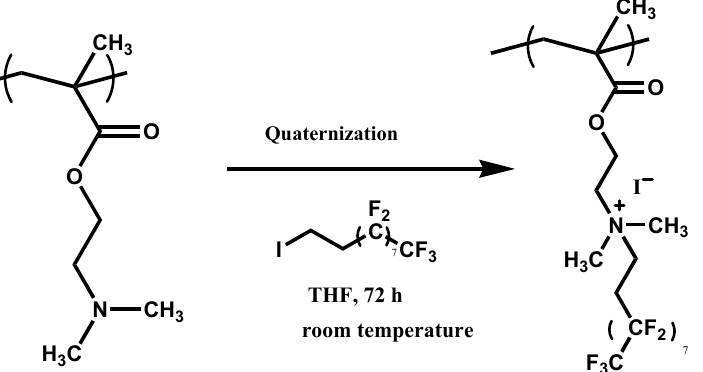
(b) Figure 2. 1 H − NMR spectra of the ( a ) quaternized PQFD 10% and ( b ) quaternized PQFD20%am- phiphilic copolymers . The peak at 7.2 ppm (*) is assigned to the solvent protons. The characteristic chemical shifts were determined based on literature data[33]. The peak a at 1.28 ppm in Figures 2a, b corresponds to the protons of the skeletal CH 2 groups, while peak b is assigned to the methyl group protons. Peaks c and d found at 4.07 ppm and 2.62 ppm, respectively, correspond to protons of ethyl groups. Characteristic peak e appearing at 2.32 ppm is assigned to protons of the tertiary amine group. Protons of the qf17 group that is attached to certain amino groups are found at 2.62 and 2.18 ppm, re- spectively. It is obvious that the peaks of the d and g proton overlap. Finally, the methac- rylate group f protons of the quaternary amine group are affected by the reagent qf17. The abovementioned protons are related to the peak that appears at 3.5 ppm. The e and f proton peaks that appear at 2.32 ppm and 3.5 ppm were used to determine